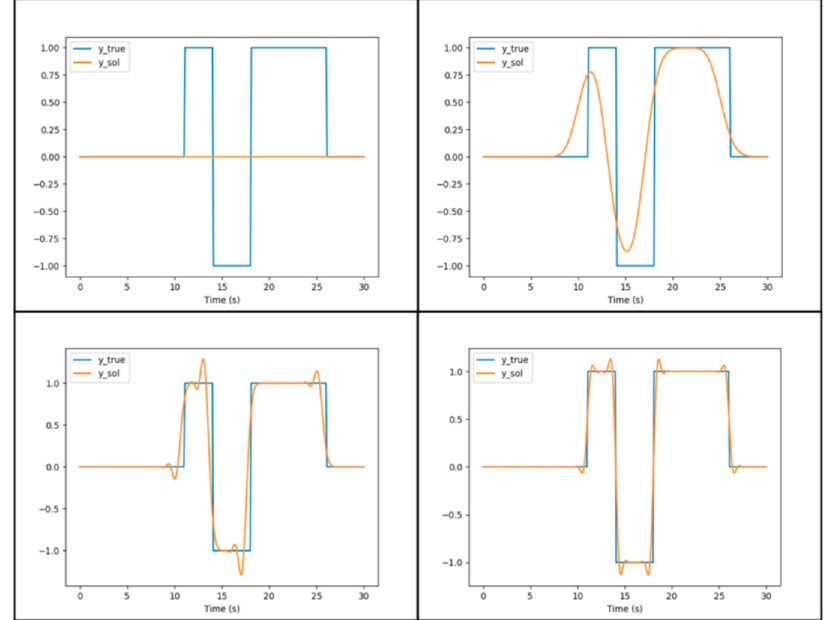
Figure A1. Progress of optimization in matching the value of the advected property at the outlet: y true is the correct analytic solution and y sol is the numerical solution.